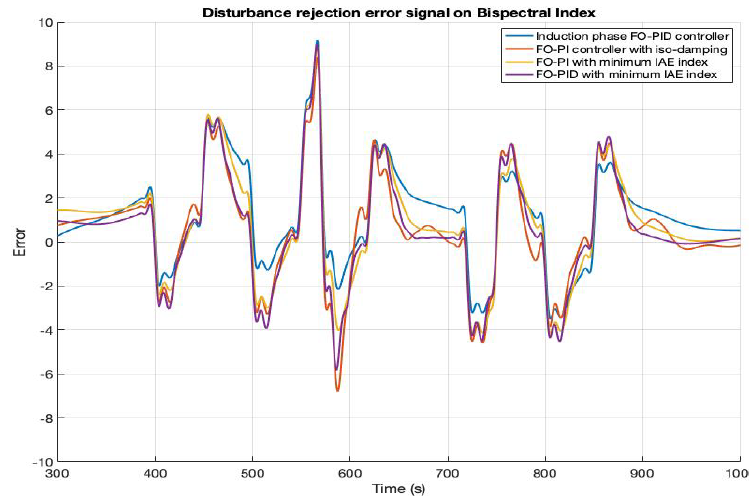
Figure 8. Comparison of error signals obtained using the different controllers designed for controlling the BIS value—simulation results for the nominal patient 1. Table 3. Numerical performance comparison of the optimized controllers.